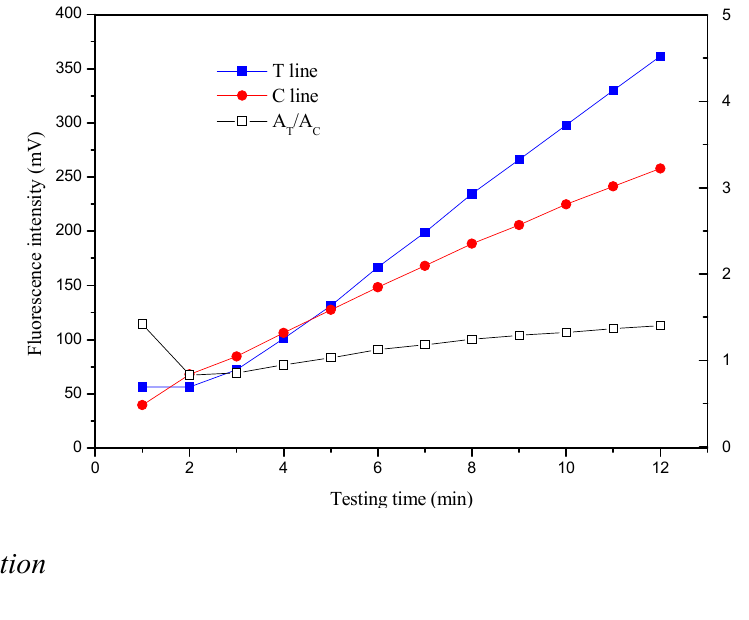
Figure 6. Trend of signals on T line and C line with time at 1,000